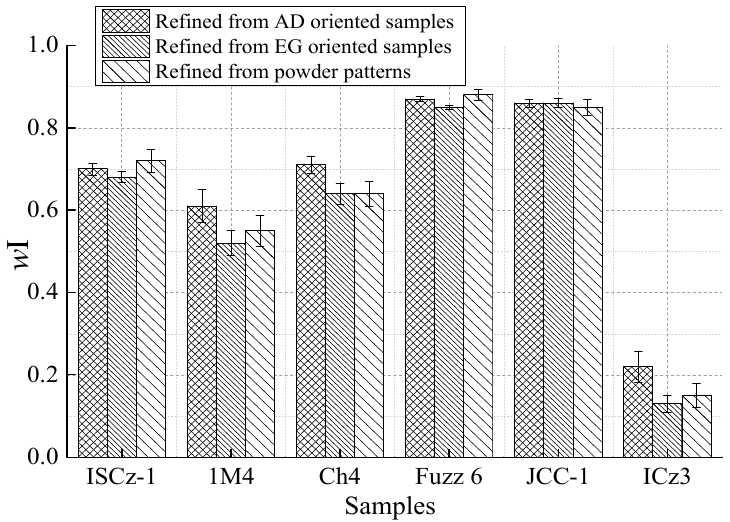
Figure 6. Refined values of proportion of illitic layers ( w I) from AD, EG and powder samples.